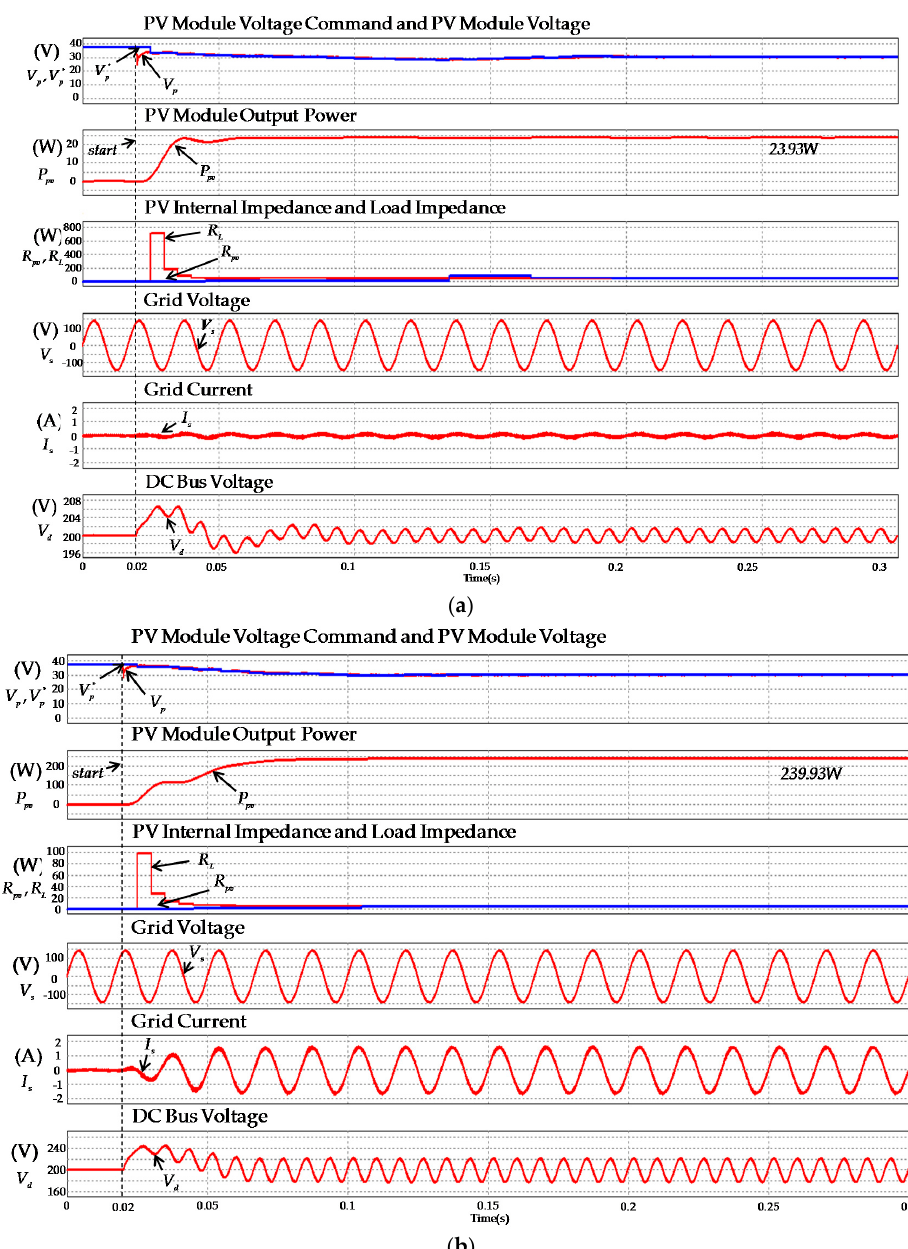
Figure 9. Improved INC MPPT controller without sensing the input current.